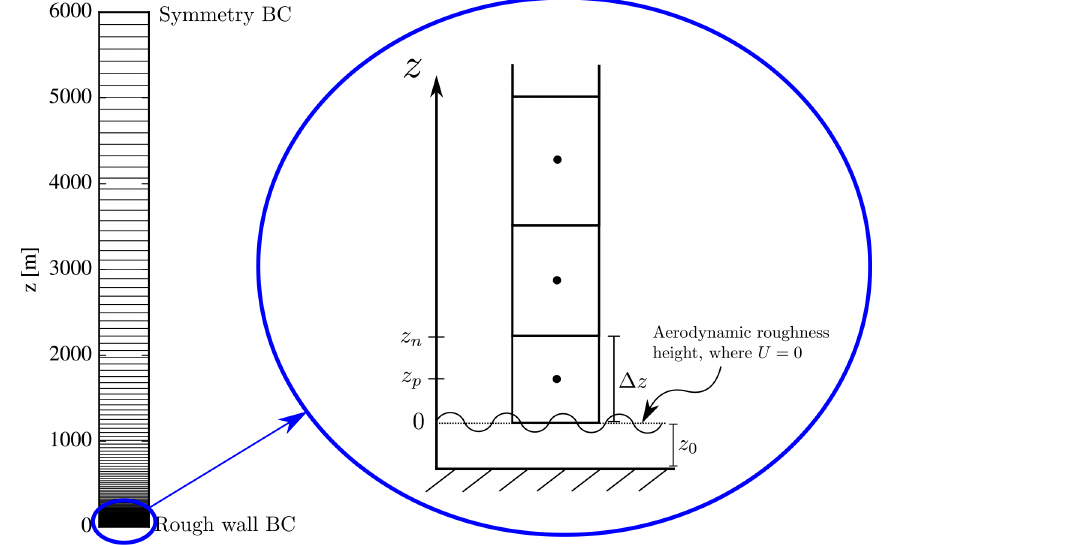
Figure 5. Half-channel EllipSys1D setup. The sketch to the right shows the convention of the coordinate system used for rough-wall simulations.